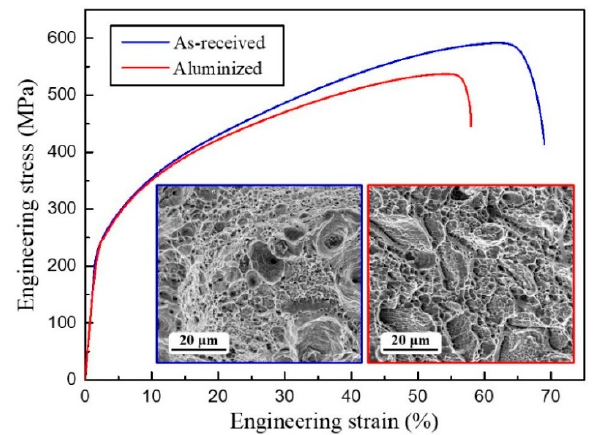
Figure 4. Engineering stress-strain curves and fracture surfaces of as-received steel and aluminized steel.